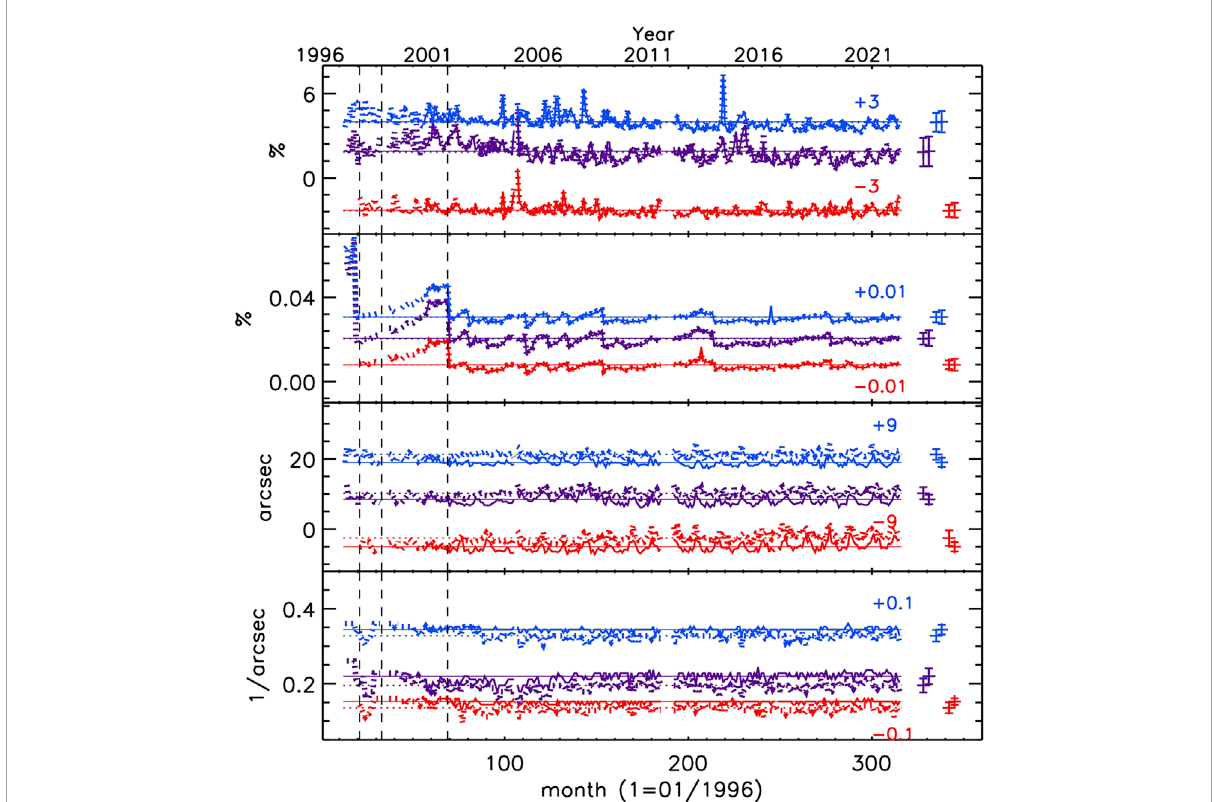
FIGURE 9 Evolution of monthly median value of the parameters measured to characterize the quality of the sum of 25 exposures (dotted lines) and single exposure (solid lines) observations. From top to bottom: level of large-scale intensity inhomogeneity at r = 0 . 5 R Sun [%], stray-light level at r = 1.05–1.07 R Sun [%], FWHM of the solar disk edge [arcsec], and cut-off frequency detected [1/arcsec] in the data taken with the Ca II K wider band (K; violet line), blue (B; blue line), and red (R; red line) filters. Vertical dashed lines mark times of instrumental discontinuities. Horizontal dashed and solid lines show the mean of the values measured on sum of 25 exposures and single exposure observations, respectively. For the sake of clarity, B and R data are shifted by the values specified in each panel. See Section 4 for more